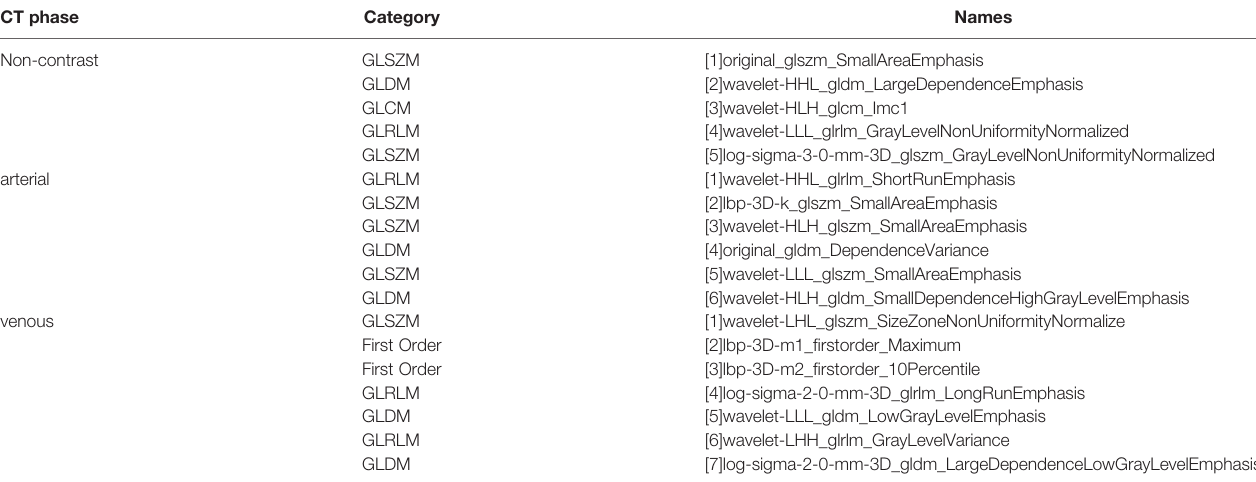
TABLE 2 | Radiomics features for each phase.